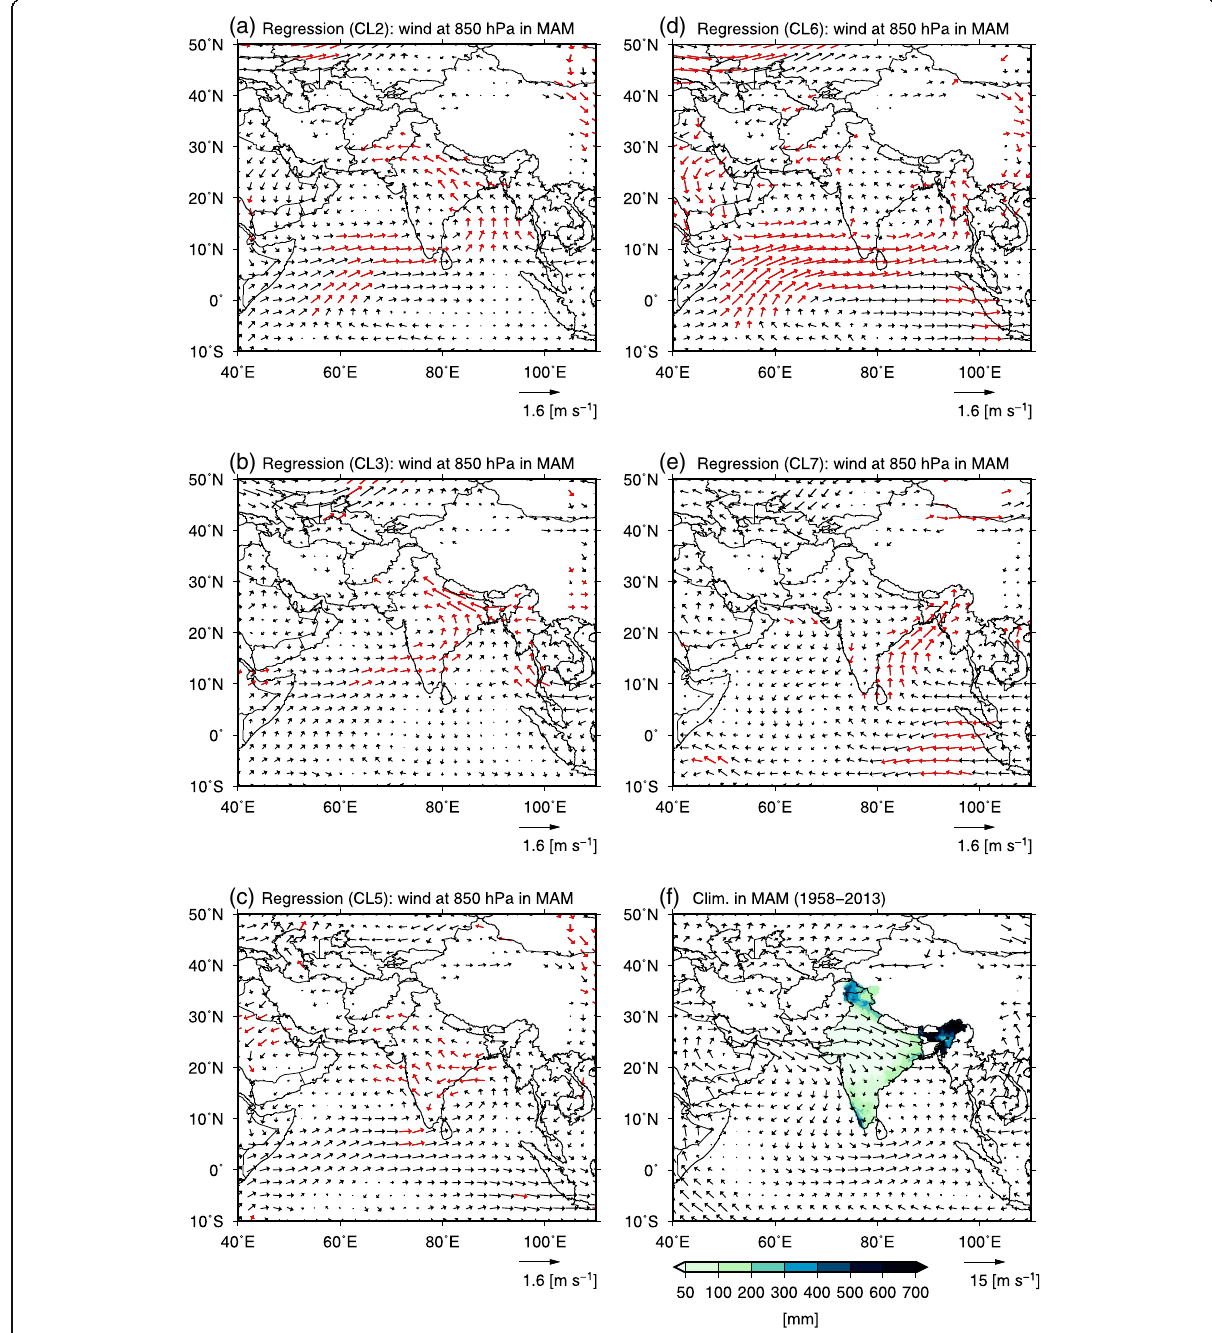
Fig. 11 Same as Fig. 7 but for the pre-monsoon season (MAM) The regression coefficient (objective variable is precipitation) between interannual variation of rainfall and the wind field at 850 hPa (m s − 1 ) (vector) for each cluster ( a ) – ( e ), and the distribution of the climatological values (averaged for 1958 – 2013) of seasonal precipitation and wind vectors at 850 hPa, as in Fig. 6a ( f